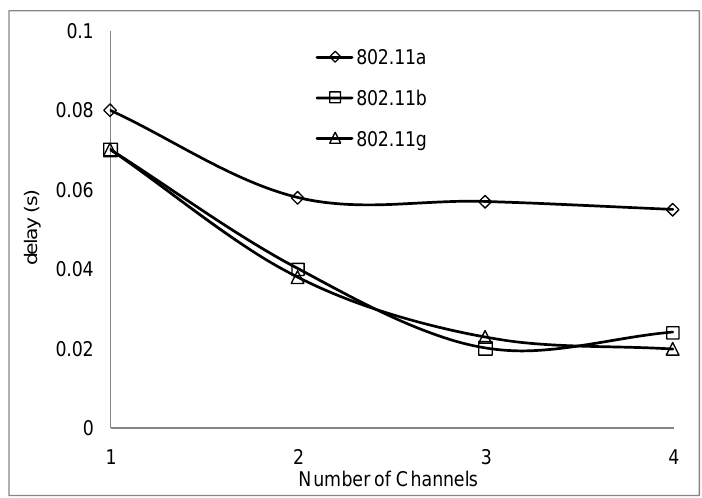
Figure 18. Delay occur at 50 m range and data rate of 2 Mbps.